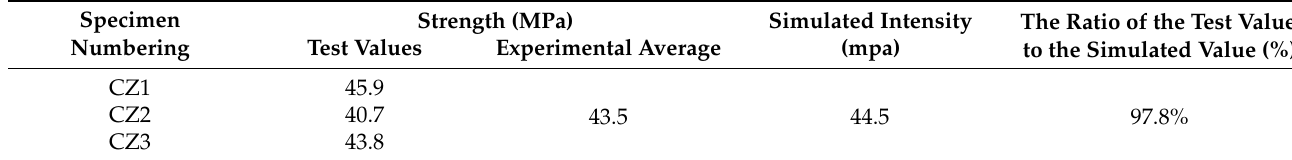
Table 20. Comparative analysis of Z-axial compression testing and numerical simulation.